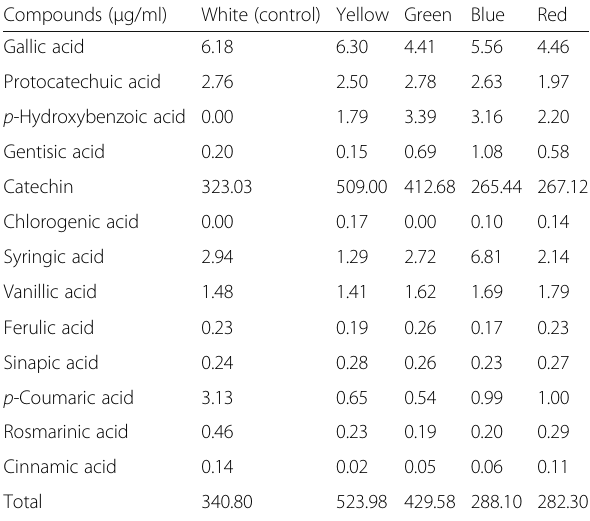
Table 3 Comparison of phenolic acids under the five different light qualities on Ceratonia siliqua L